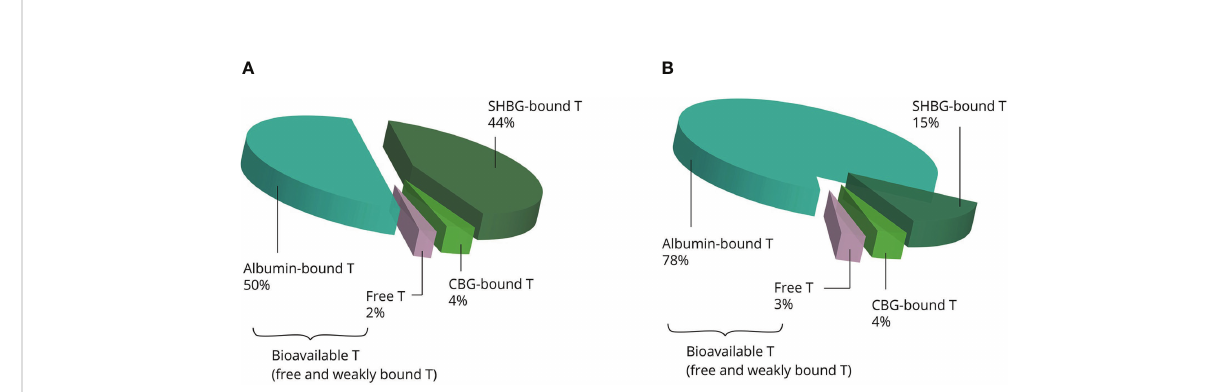
FIGURE 2 Examples of the estimated distribution of testosterone bound to binding proteins at physiological concentrations (A) and supraphysiological concentrations (B) . The albumin-bound and unbound fractions become larger, whereas the SHBG-bound fraction becomes smaller with increasing concentrations. Abbreviations: SHBG, sex hormone-binding globulin; CBG, corticosteroid-binding globulin; T,